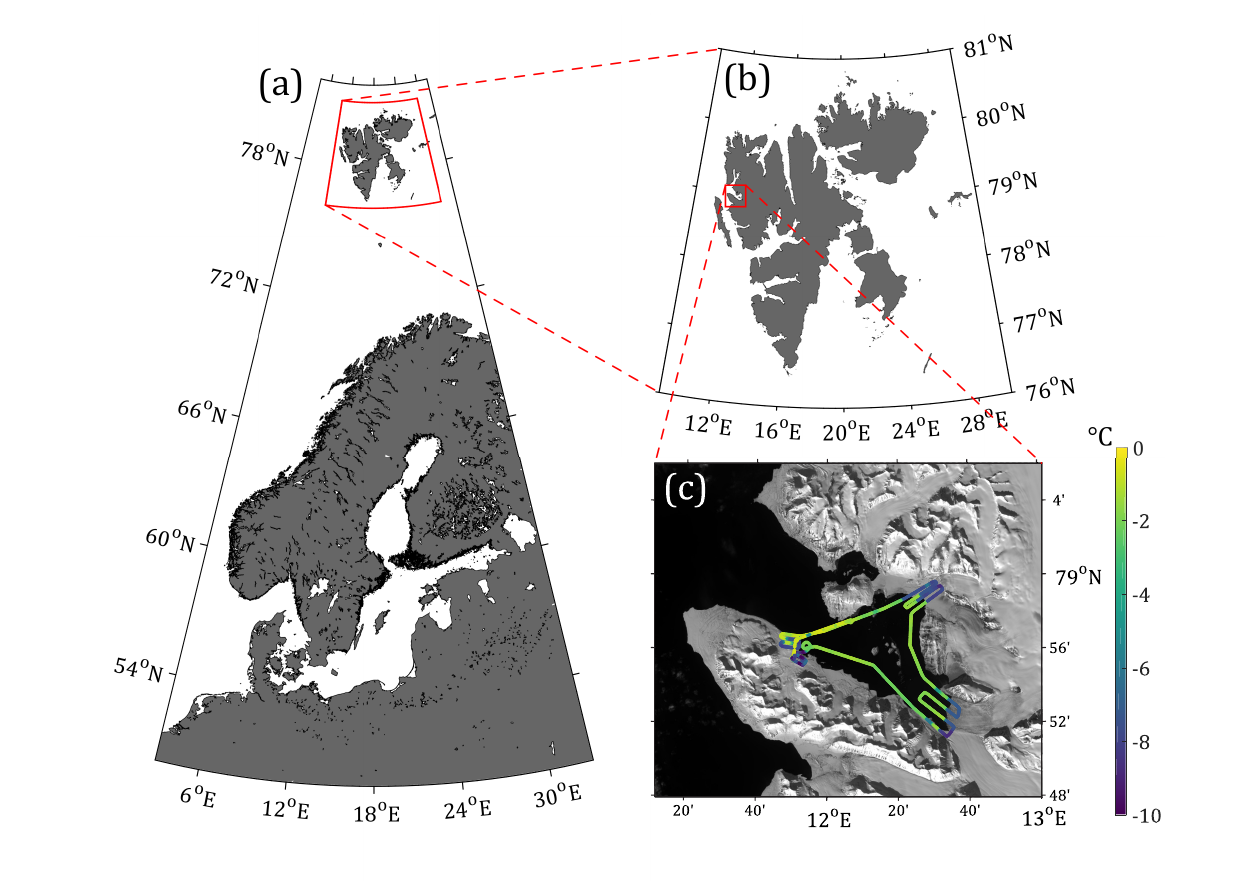
FIGURE 2 | (a) Norway, Sweden, Finland, and Eastern Europe, with Svalbard boxed in red (North up); (b) zoom of red box in (a) highlights Svalbard as a whole; (c) zoom of red box in (b) showing a single fjord where the Ny-Ålesund base is located, with a map of payload-recorded surface brightness temperature on 29 April 2015 overlaid onto a 60 km × 60 km Landsat image from the same day. The surface temperature standard deviation of the fjord water): 0.332 ◦ C.